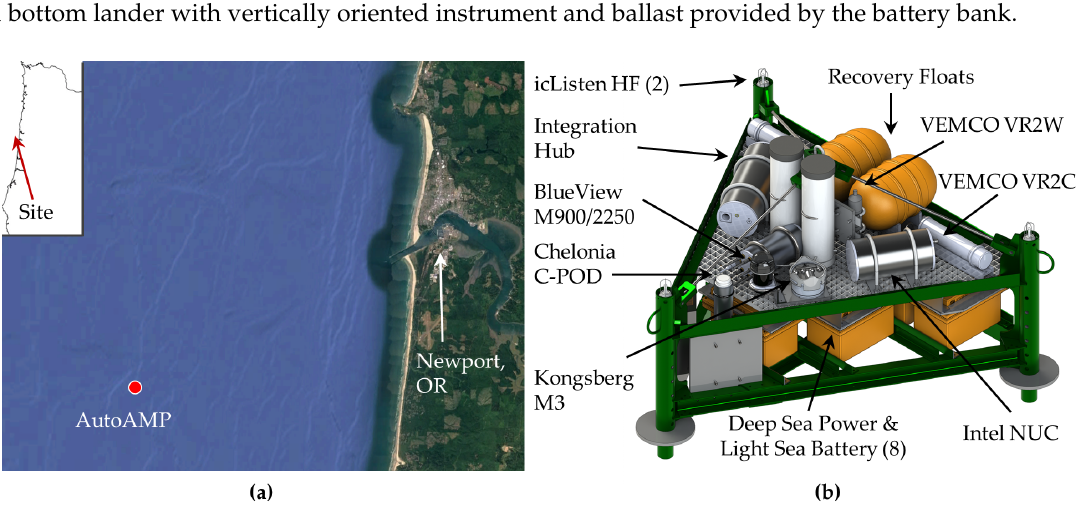
Figure 5. AutoAMP deployment showing ( a ) site layout and ( b ) AMP